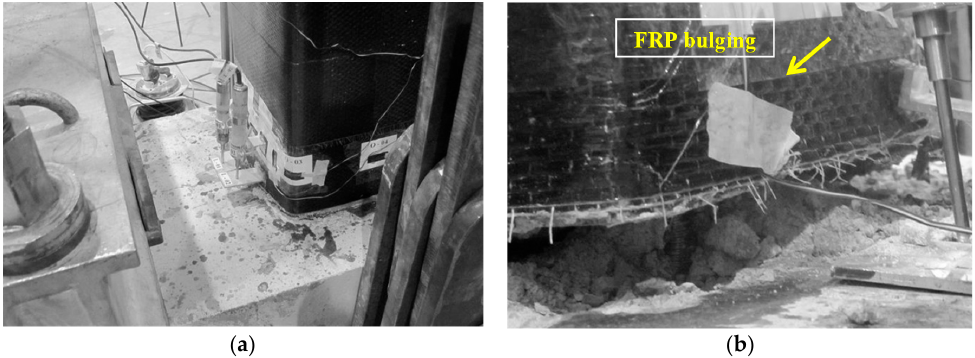
Figure 16. Damage of specimens strengthened with the system “type B”.